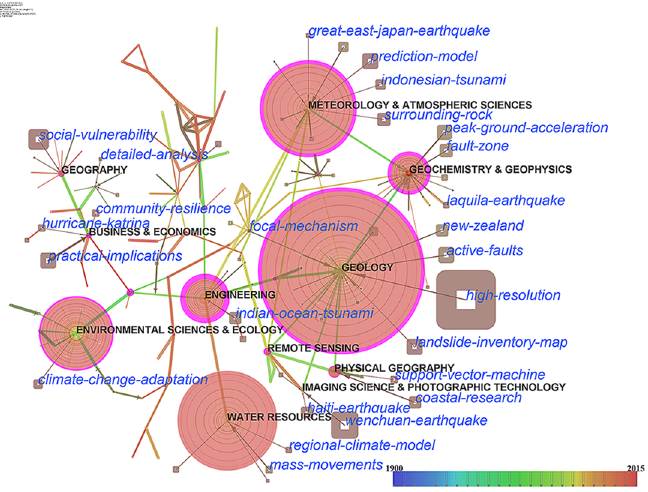
Fig 4. A hybrid network of disciplines and hot topics of 194 nodes and 246 links. Circular nodes represent disciplines. Square nodes represent topics. The color of the ring of a circle is corresponding to the year. The size of a circle is in proportion to the number of literatures of the discipline. The purple rims of circles represent the high betweenness centralities. The size of a square is in proportion to the frequency of the topic.